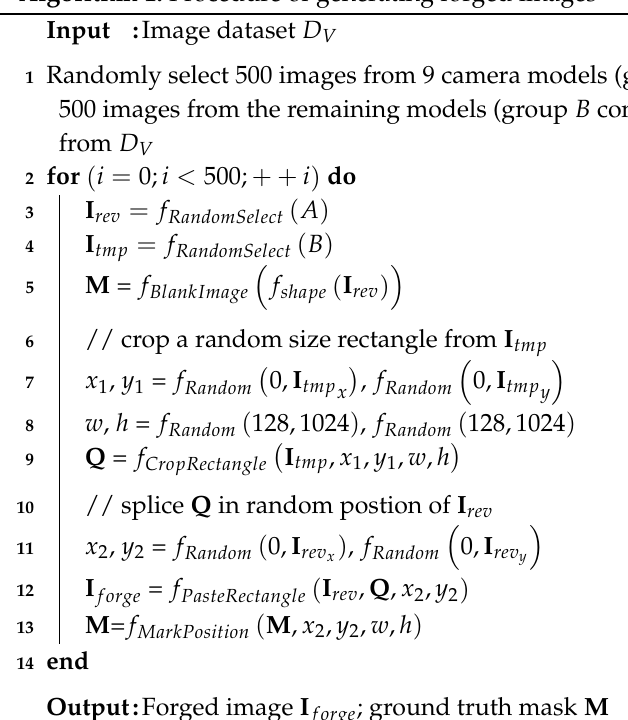
Algorithm 1: Procedure of generating forged images Input : Image dataset D